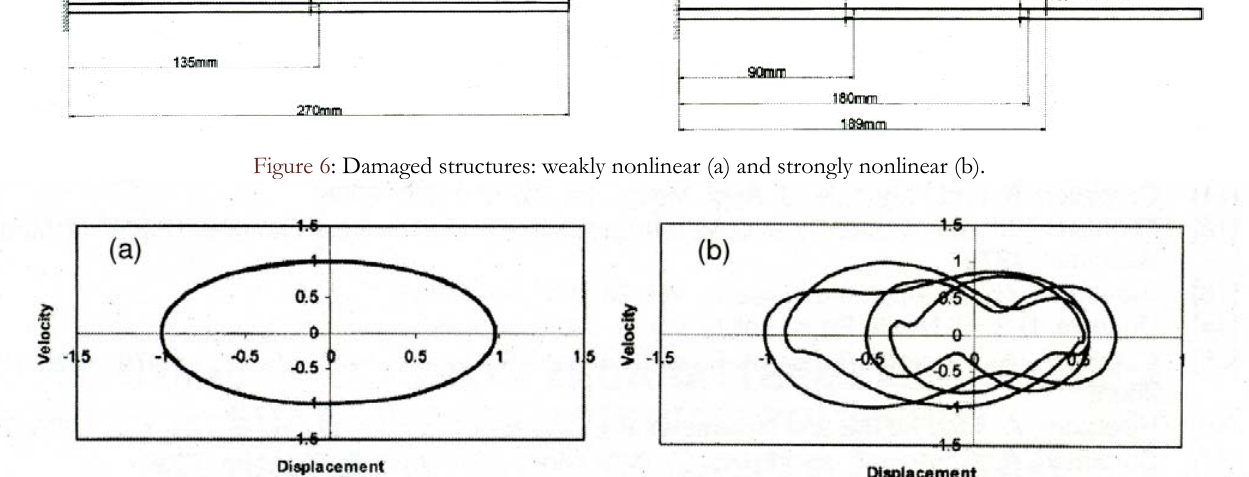
Figure 7: Dimensionless phase diagram of the response (free end displacement): weakly (a) and strongly (b) non linear